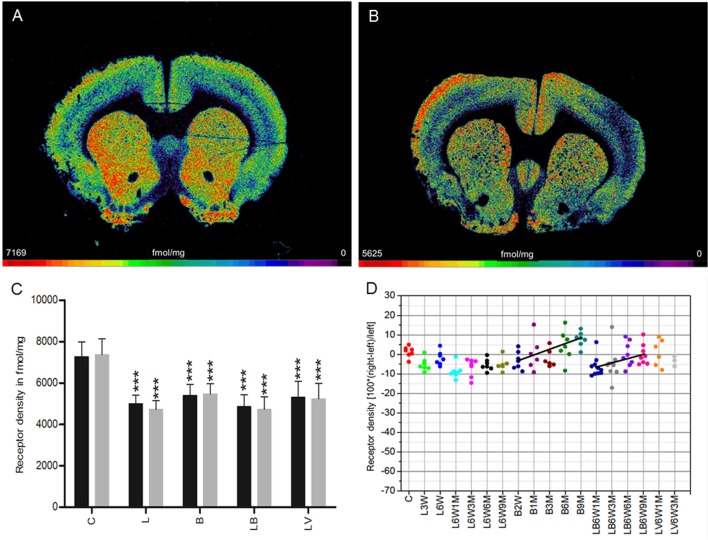
(A,B) Contrast-enhanced color-coded images showing the regional distribution of M3 receptor density labeled with [3H]4-DAMP in a control rat (A,B) after 6-OHDA lesion (group L6W1M) in a control rat (A) and after 6-OHDA lesion (group L6W1M) (B). (C) Mean receptor density (fmol/mg protein; averaged over all post-lesion survival times) in the left/contralateral (black column) and right/ipsilateral hemispheres (gray column) of the five groups (see Figure 1). All data is expressed as means ± SD. Asterisks mark significant differences to the respective side of controls (***p < 0.001). (D) Scatter plots and regression analyses of the right-left differences of M2 receptor density for all 18 groups and time points (five groups with different survival times); see Table 1 for explanation of abbreviations. Significant regressions are labeled by a continuous line.